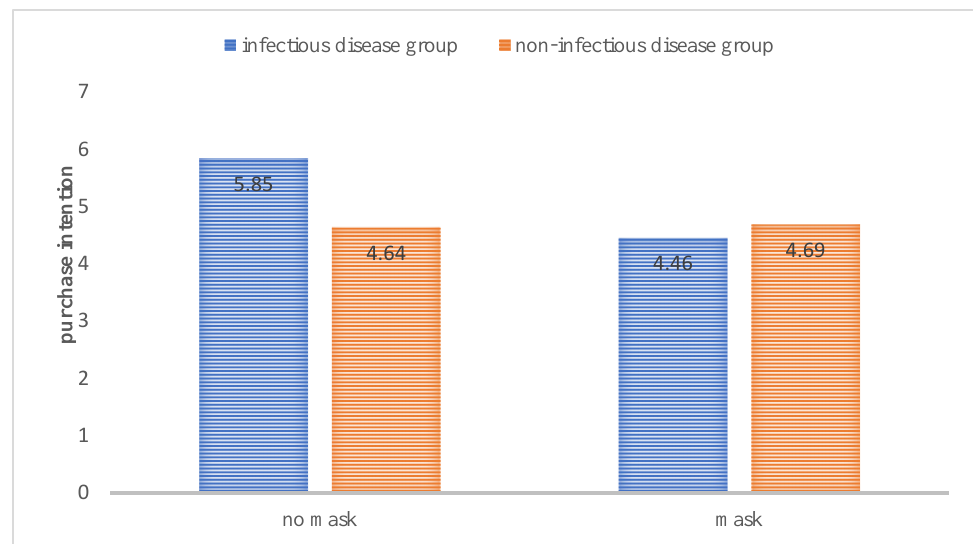
Figure 4. The moderating effect of anti-disease intervention on consumers’ purchase intention of eco-friendly products.